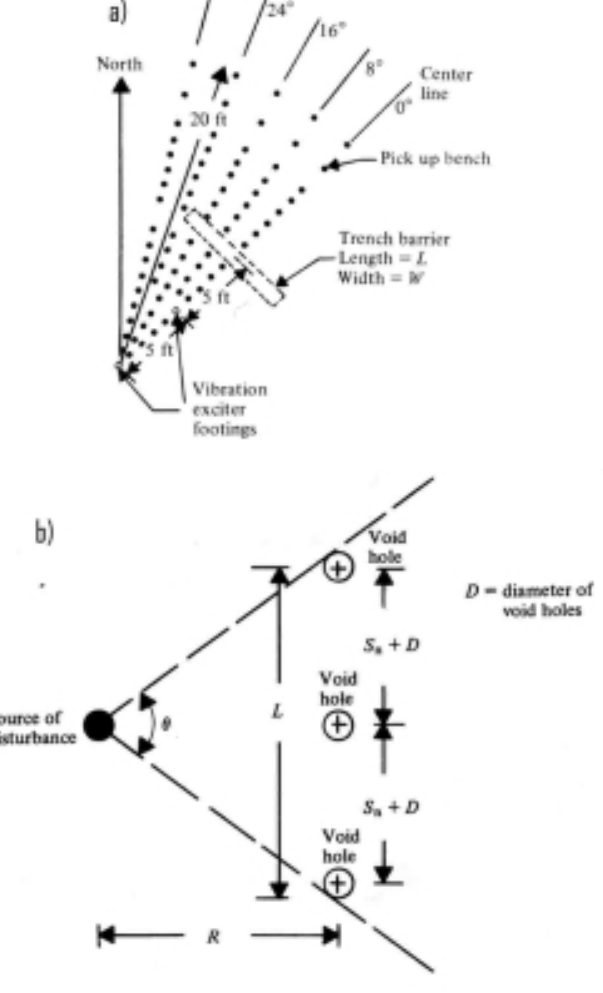
Fig. 2. Passive isolation tests, the plan view of (a) field site, and (b) the model half-space in a box of layouts in